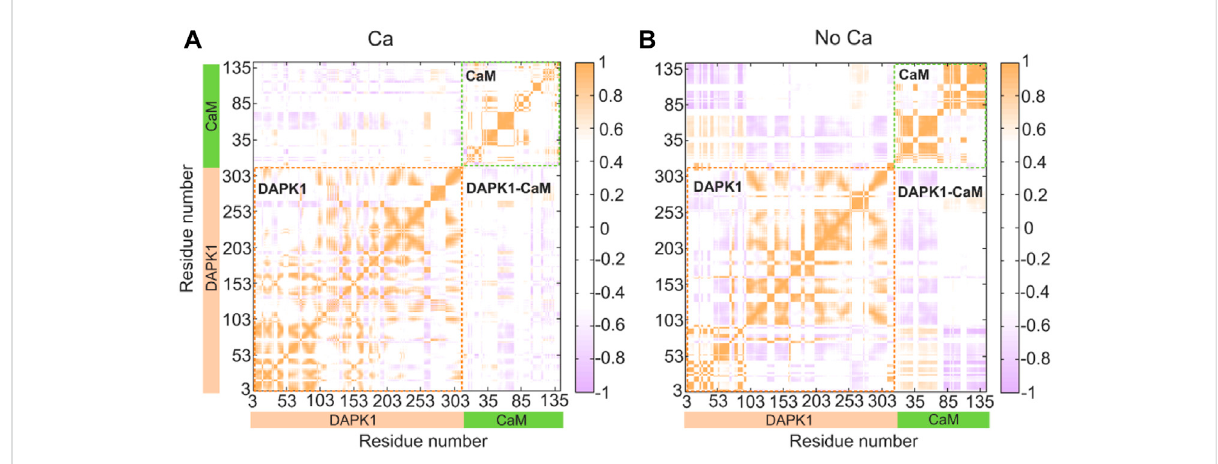
Intra- and inter-domain correlation of the DAPK1 − CaM in the Ca 2+ -bound (A) and-unbound (B) states. Positive regions (orange) stand for correlated motions,while negative regions (light blue) represent anti-correlated motions. The absolute values ofthecoef fi cients ( < 0.4)are shown in white for